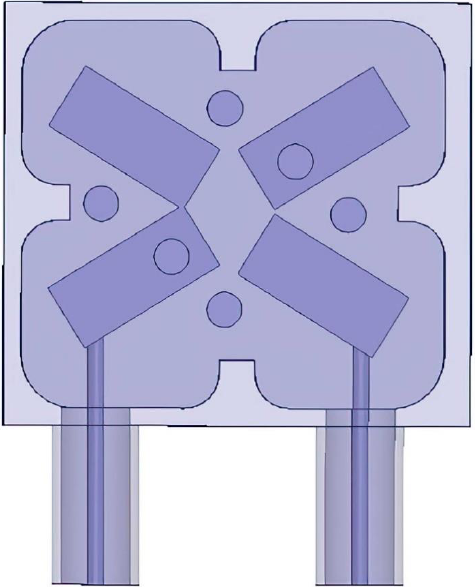
Figure 6. Design of the proposed quad-mode band pass filter (top view). Tuning screws placed in the resonant cavities, which can be adjusted externally to the waveguide, provides fine tuning of the resonant frequency by adding more or less thread to the waveguide. Tuning screws in each cavity are sealed with jam nuts and thread-locking compounds. The equivalent circuit is a shutter condenser with a value rising as the screw is inserted for screws inserted at just a small distance as shown in Figures 7 and 8. The screw has been inserted at a distance of λ/4 which is equal to a sequence of LC circuits. Inserting it further allows the impedance to change from capacitive to inductive, i.e., the arithmetic sign shifts. Elliptic characteristic responses receive numerous with the aid of using cross-couplings among non-adjoining cavities and the symptoms of those couplings are decided with the aid of using the orientations of the tuning screws relative to each other.